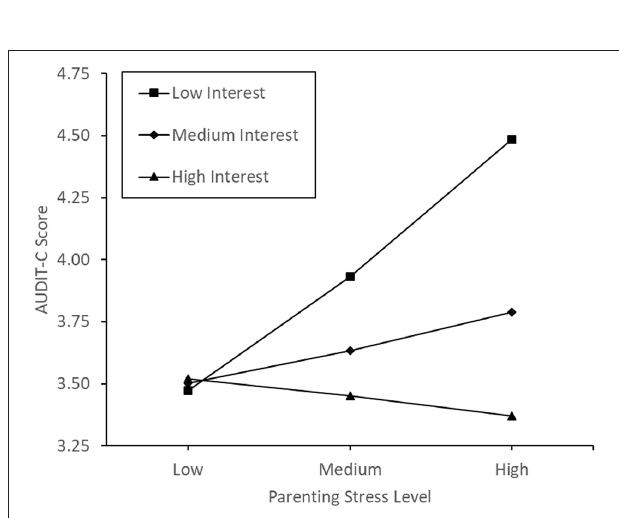
FIGURE 5 | Conditional effects of parenting interest on the correlation between parenting stress and alcohol